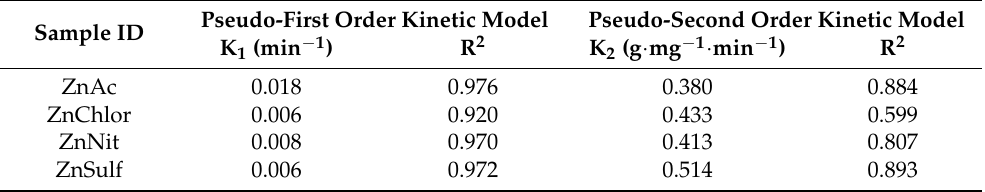
Figure 14. Photocatalytic kinetic model studies for the four different ZnO powders, produced by different precursors, following ( a ) a pseudo-first order model and ( b ) a pseudo-second order model, upon UV light photocatalysis. Table 9. Kinetic parameters of the ZnO powders under UV light photocatalysis.